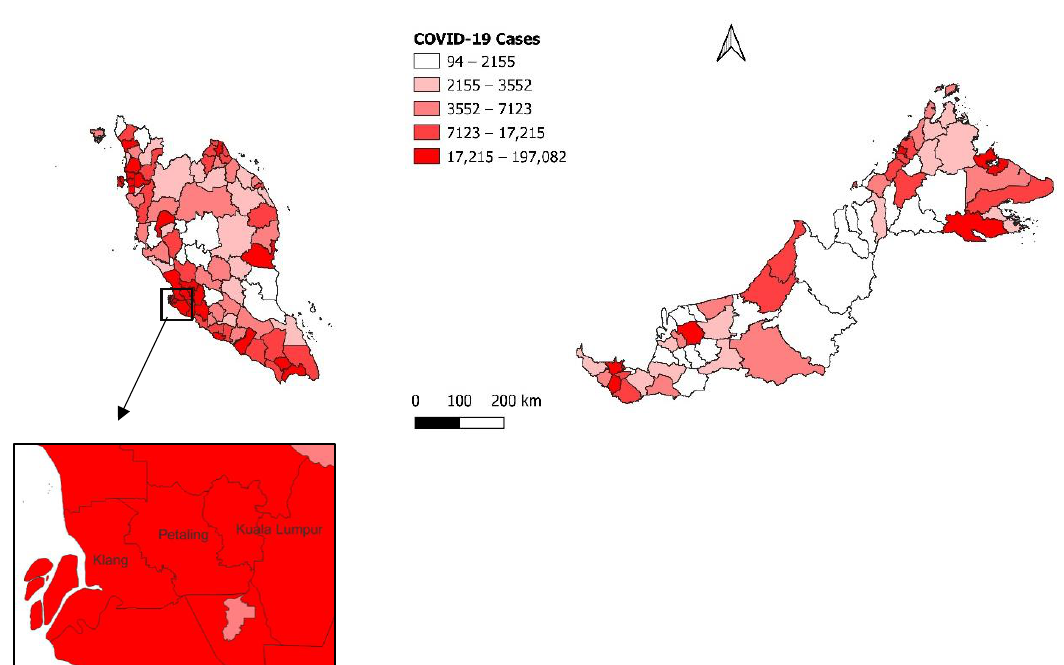
Figure 1. Distribution of COVID-19 cases by district, 20 September 2020 to 19 September 2021, Malaysia.